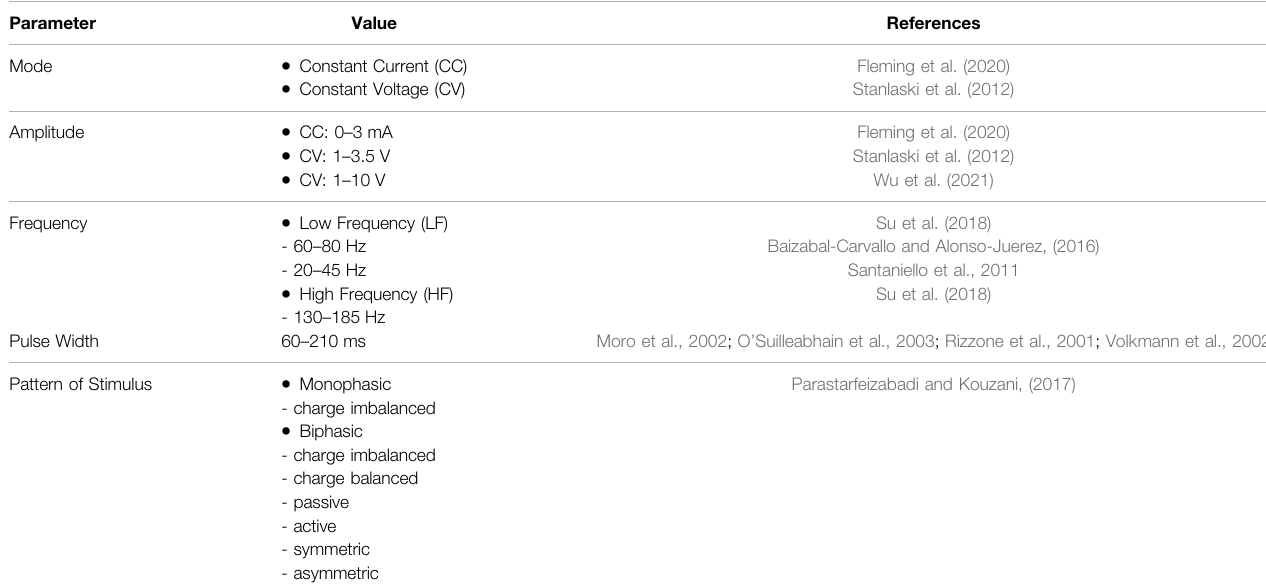
TABLE 2 | Typical DBS parameter